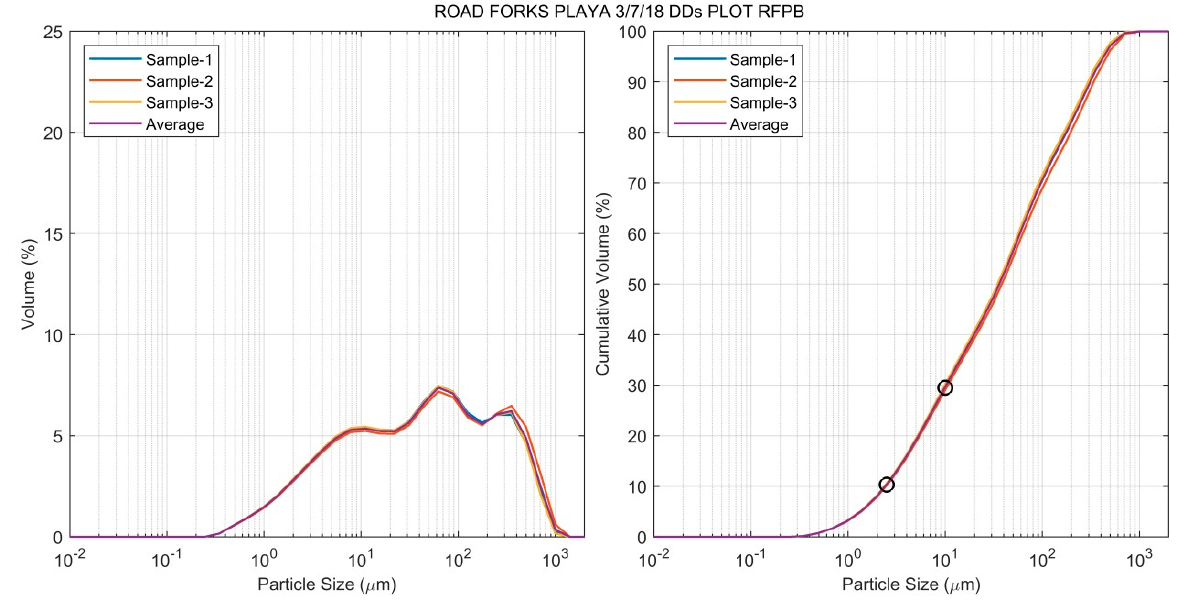
Figure 6. Grain size distribution of the soil at the Road Forks field.